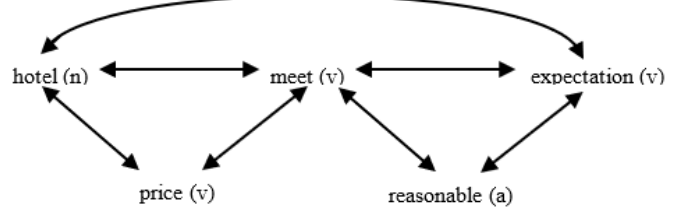
Figure 4. An example of a lexical graph.